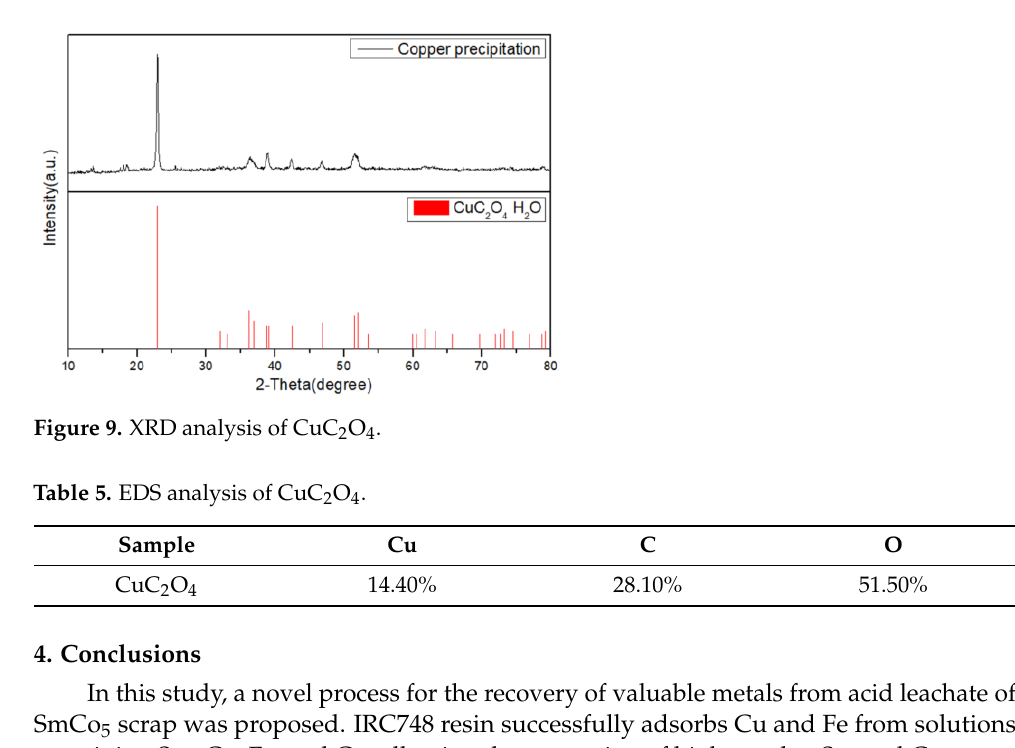
( d ) Figure 8. Effects of ( a ) oxalate to Cu molar ratio, ( b ) temperature, ( c ) time, and ( d ) pH on the Cu precipitation. The precipitate obtained was analyzed by X-ray diffraction (XRD) and energy-dis- persive spectroscopy (EDS). Figure 9 displays the results of XRD analysis and the major